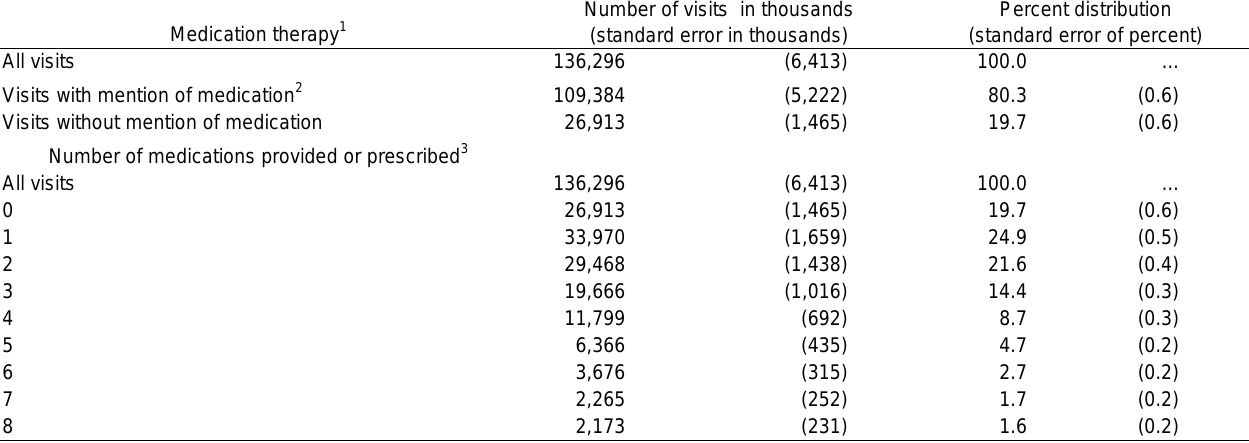
Table 20. Medication therapy and number of medications mentioned at emergency department visits: United States, 2011